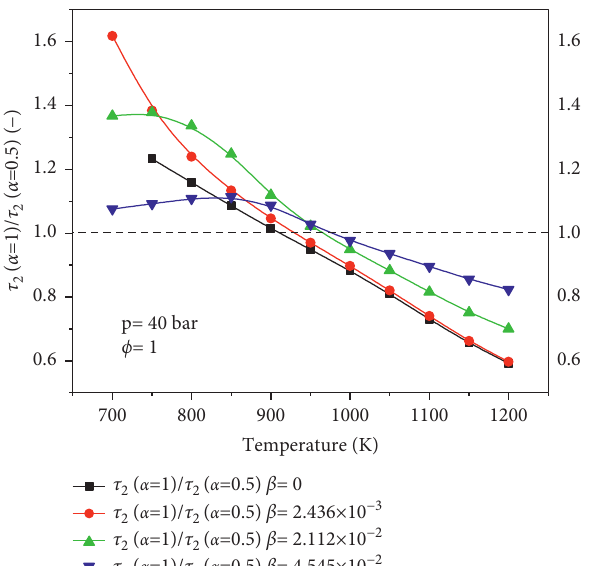
p � 40 bar 2 /n-heptane mixtures at